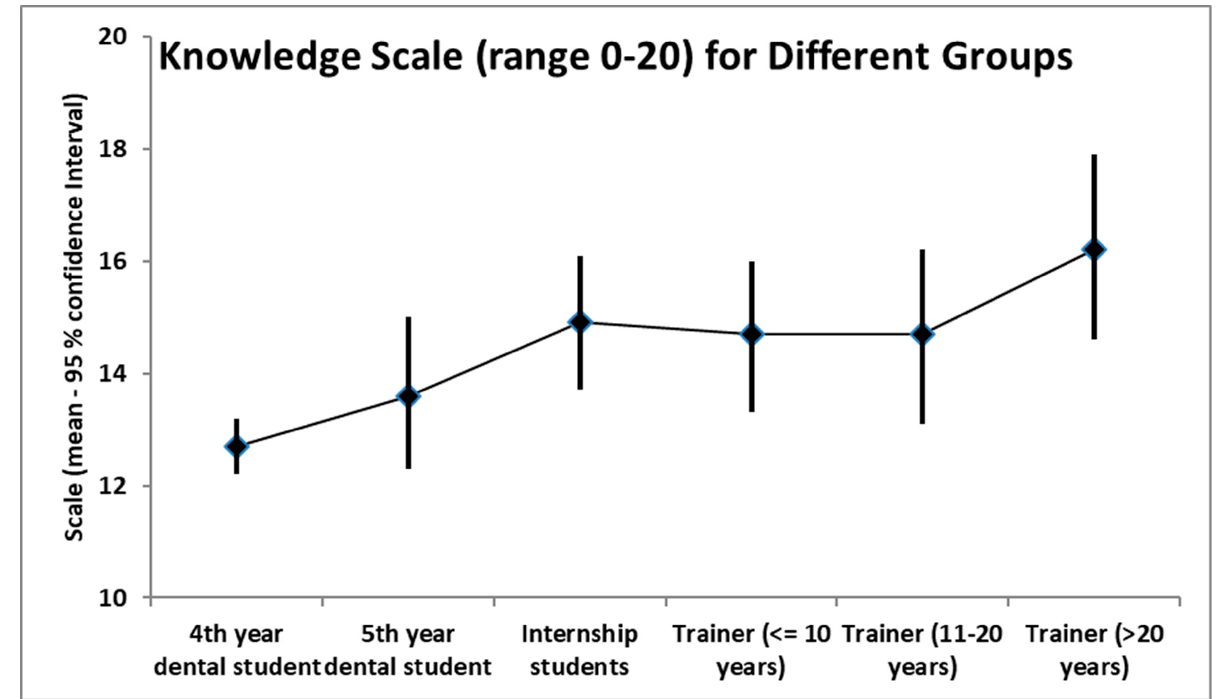
Figure 1. Knowledge scale for the different groups of participants. Knowledge scale ranges between 0 and 20. Table 4. Participants’ self-evaluation of their training, knowledge, and clinical competency in the management of medical emergencies.